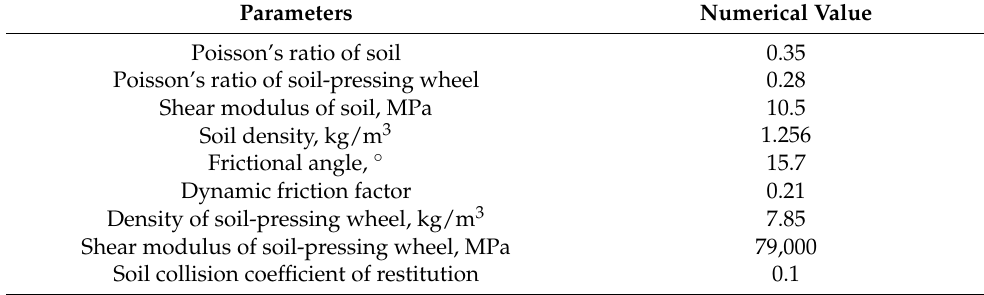
Table 2. The simulation parameters of the compacting process.